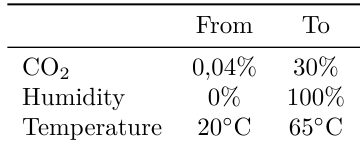
Table 2. Range of reaction